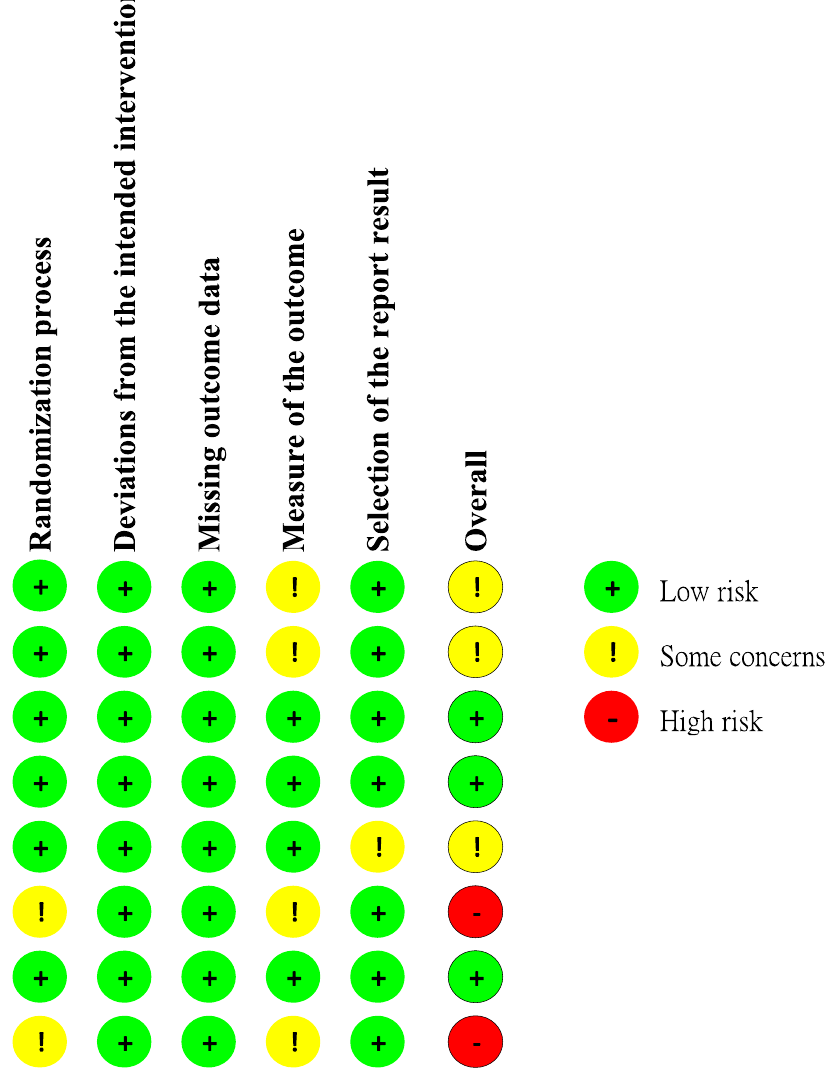
Figure 2. Risk of bias. Studies included Lin et al [11], Teng et al [12], Riccio et al [13], Mazzeffi et al [14], Thiruvenkataragan et al [15], Kim et al [17], Nay et al [16], Lee et al [18].